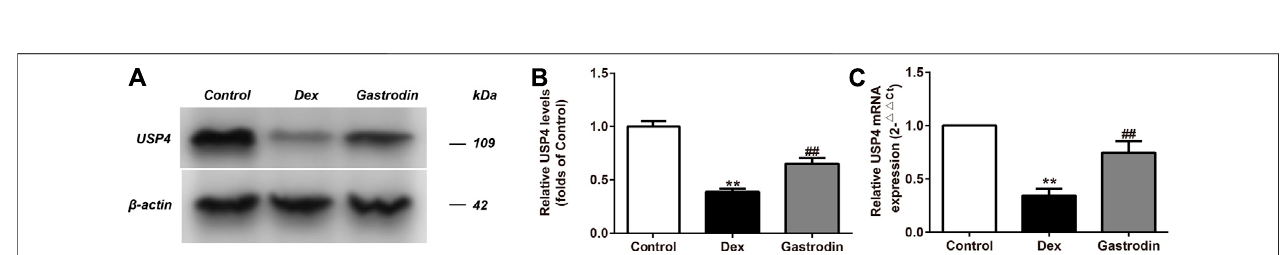
FIGURE 11 | The levels of USP4 expressions and mRNA expressions of USP4 in HepG2 from different groups. The representative bands were shown in (A) . The levels of USP4 (B) were normalized to Dex. The mRNA levels of USP4 (C) was normalized to Dex. The concentration of gastrodin was 100 μ M. The results were presented as mean ± SD ( n (cid:1) 3). ** p < 0.01, vs. Control group, ## p < 0.01, vs. Dex group.